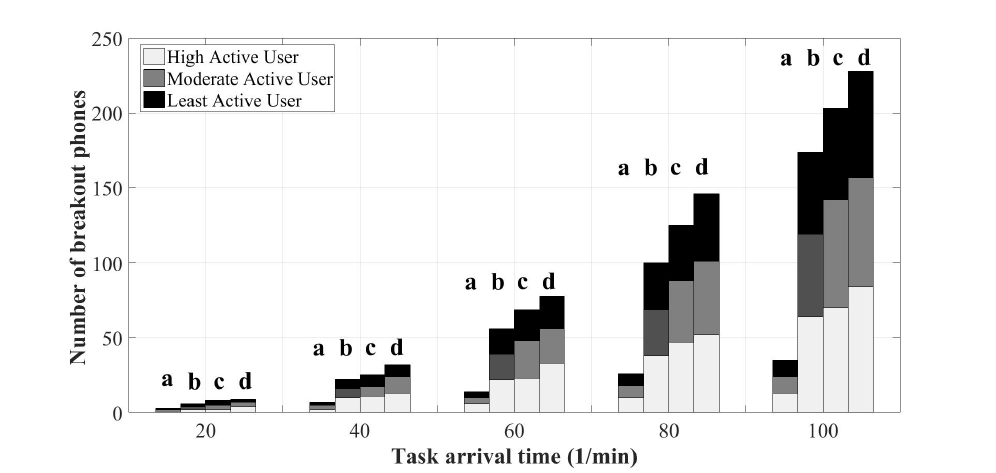
Figure 15. Number of breakout mobile phones: ( a ) mobile crowd-sensing benchmark; ( b ) SOBER-MCS with (cid:60) = 10%; ( c ) SOBER-MCS with (cid:60) = 15%; and ( d ) SOBER-MCS with (cid:60) =